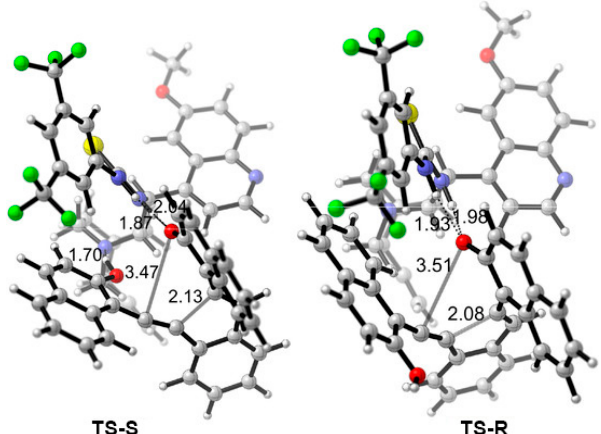
Figure 40. TSs for the cycloaddition step of the ent- C19 -catalyzed intramolecular [4 + 2] cycloaddition reaction. Bond lengths are in Å. Reprinted and adapted from Chemistry—An Asian Journal with permission from Wiley [79].